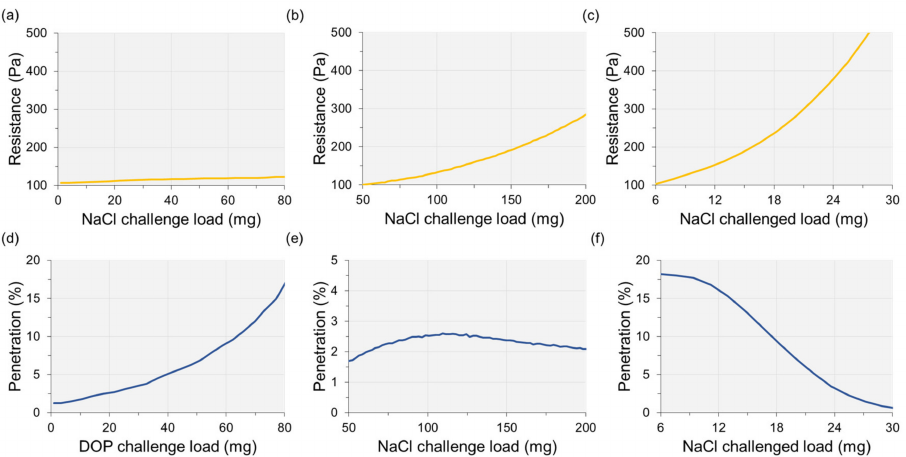
Figure 4. Resistance and penetration of filter materials with mass loading of solid and oily aerosols at 85 LPM. ( a ) Resistance of oily aerosol; ( b ) Resistance of solid aerosol for a loosely packed electret filter; ( c ) Resistance of solid aerosol for a dense filter; ( d ) Penetration with oily aerosol; ( e ) Penetration with solid aerosol for a loosely packed electret filter; ( f ) Penetration with solid aerosol for a dense filter. Tests were conducted by the authors.